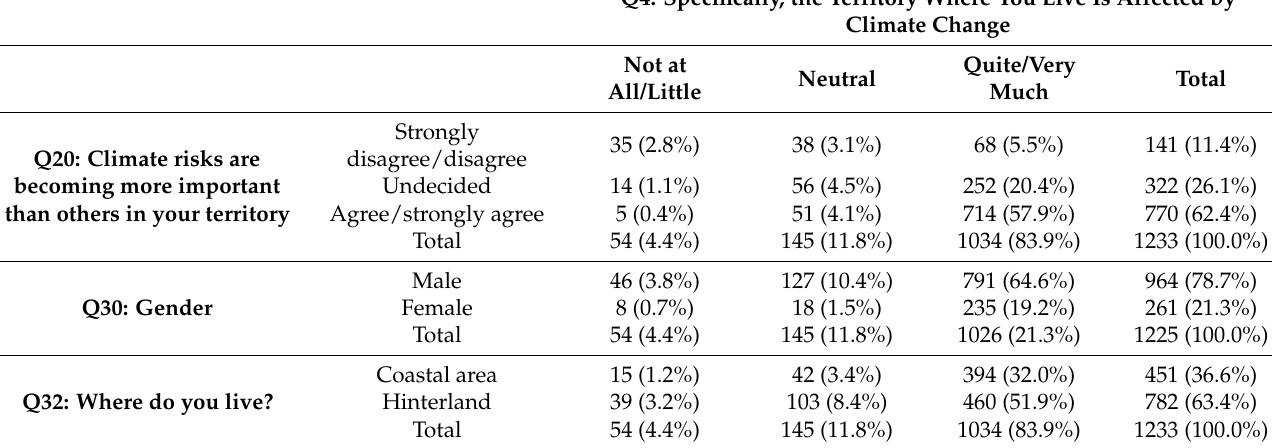
Table 4. Cross table of Q20 and Q4, Q30 and Q4, and Q32 and Q4 with frequencies (percentages) of the answers.